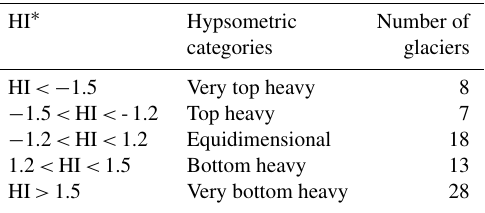
Table 4. Hypsometric index (HI) and glacier basin category descrip-